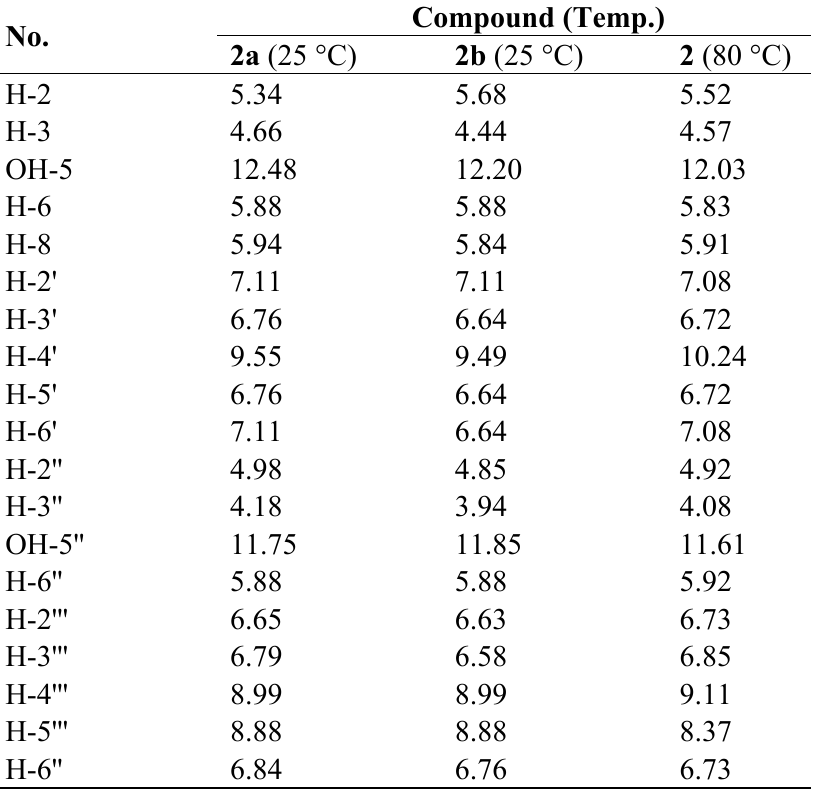
( δ , ppm). 2a,b are related to the two conformers 6